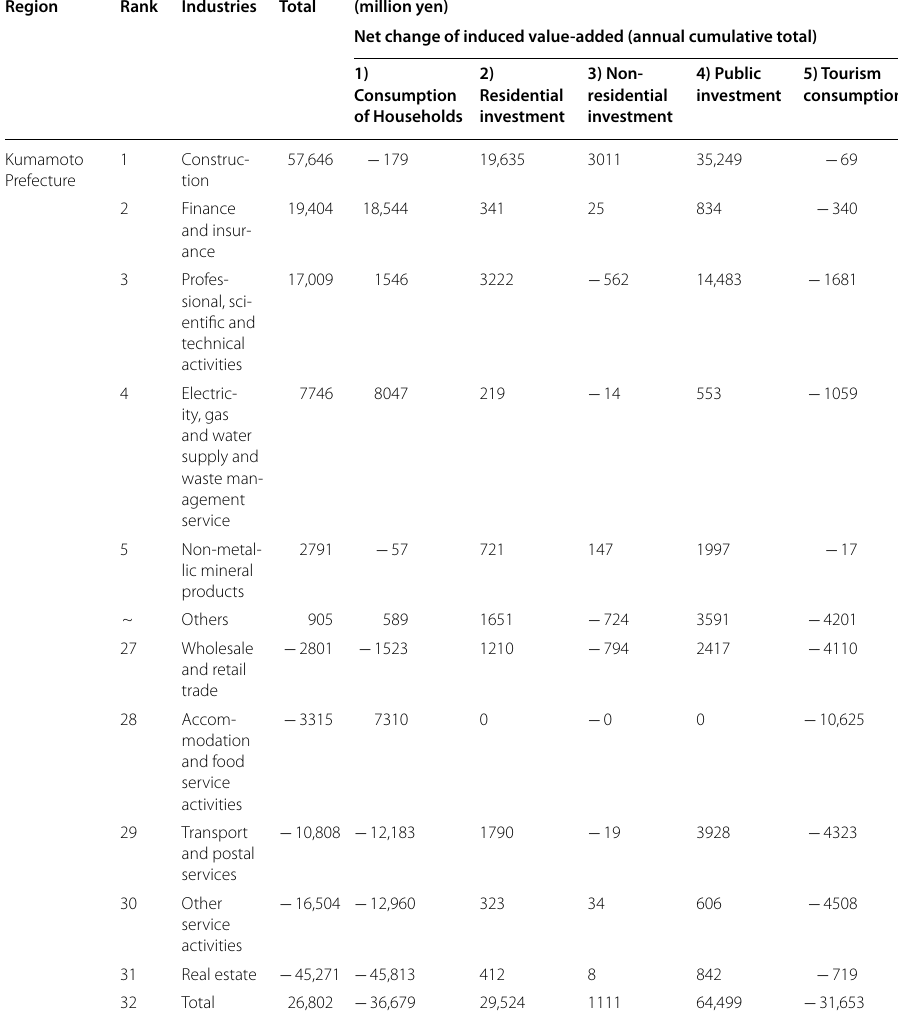
Table 6 Change of induced value-added (annual cumulative total, 31 sectors) Region Rank Industries